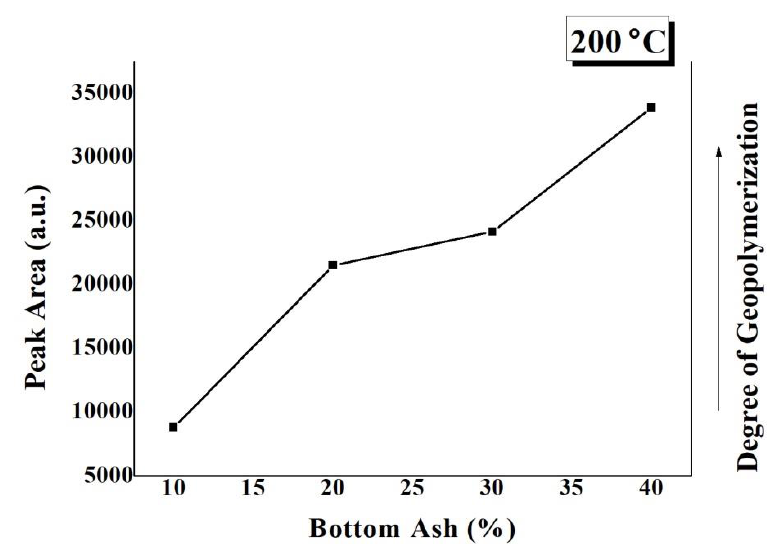
Figure 6. Degree of geopolymerization dependence on bottom ash content.